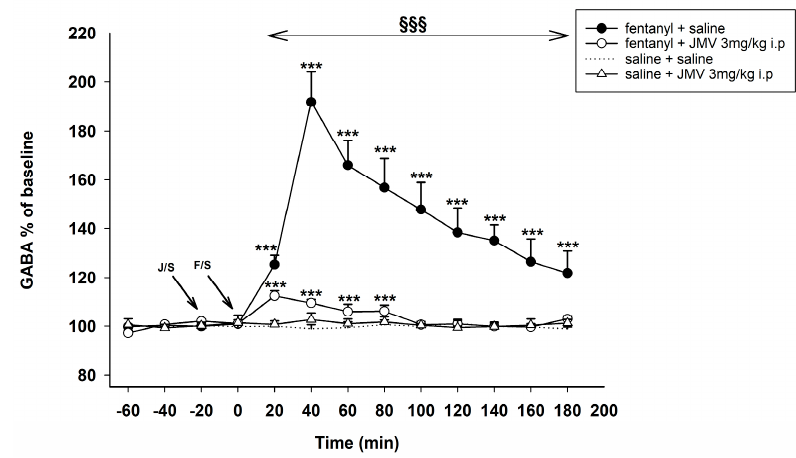
Figure 5. Effects of GHS-R1A antagonist JMV2959 3 mg/kg i.p. on the fentanyl-induced accumbens γ -aminobutyric (GABA) concentration. JMV2959 was administered following three 20 min baselines and 20 min before fentanyl/saline (means ± SEM). The effects are illustrated as follows: saline + fentanyl (filled circle), 3 mg/kg JMV2959 + fentanyl (open circle), 3 mg/kg JMV2959 + saline (open triangle), saline + saline (dotting). Differences to saline + saline group are expressed as *** p < 0.001. Differences between fentanyl + saline and 3 mg/kg JMV2959 + fentanyl effects are expressed as §§§ p < 0.001. The horizontal arrow shows intervals with appropriate significant changes ( §§§ ); the oblique arrows show the time of administration of J/S= JMV2959/saline and F/S = fentanyl/saline.